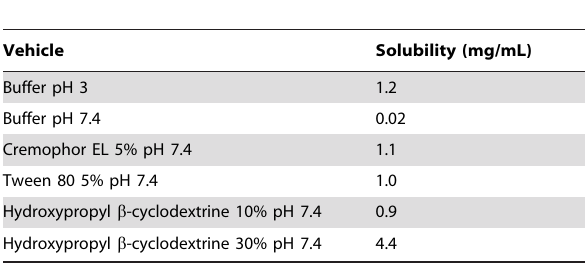
Table 1. Formulation development for injectable (S)-roscovitine.